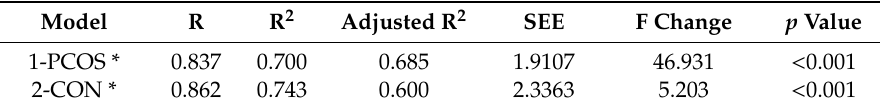
Table 7. Multiple stepwise forward regression between monocyte-to-HDL ratio (MHR) and selected predictors in PCOS and CON groups / Multivariate logistic regression analysis of factors related to / a ff ecting monocyte-to-HDL ratio (MHR) in PCOS and CON groups. Model R R 2